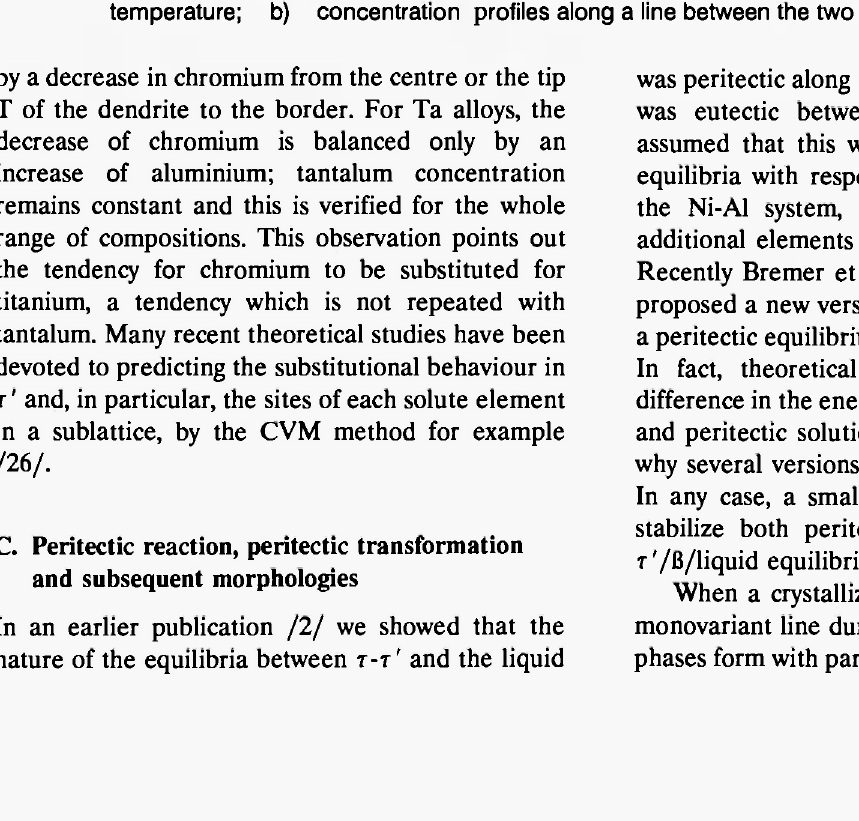
Fig. 6: Top: a) Electron micrograph for alloy 75Ni-5Cr-11Ti-9AI quenched at the liquidus temperature; b) concentration profiles along a line between the two arrows (120 μηη). Bottom: a) Electron micrograph for alloy 67Ni-10Cr-13AI-1GTa quenched at the liquidus temperature; b) concentration profiles along a line between the two arrows (90